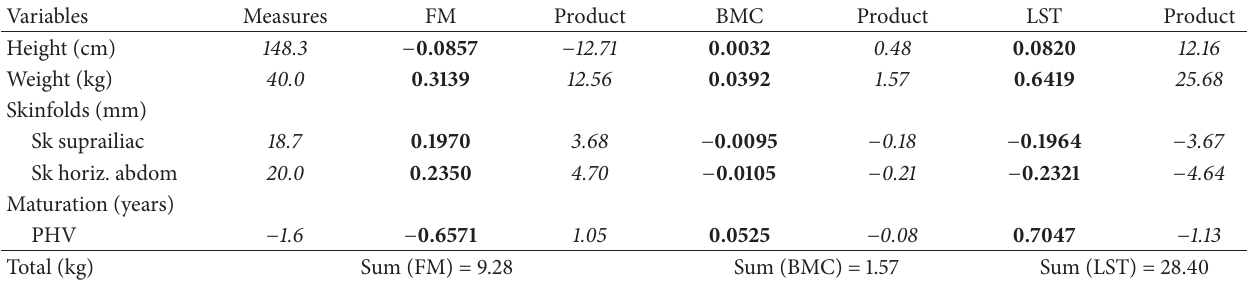
Table 5: A worked example for predicting fat mass (FM), bone mineral content (BMC), and lean soft tissue (LST) for a boy. Variables Measures FM Product BMC